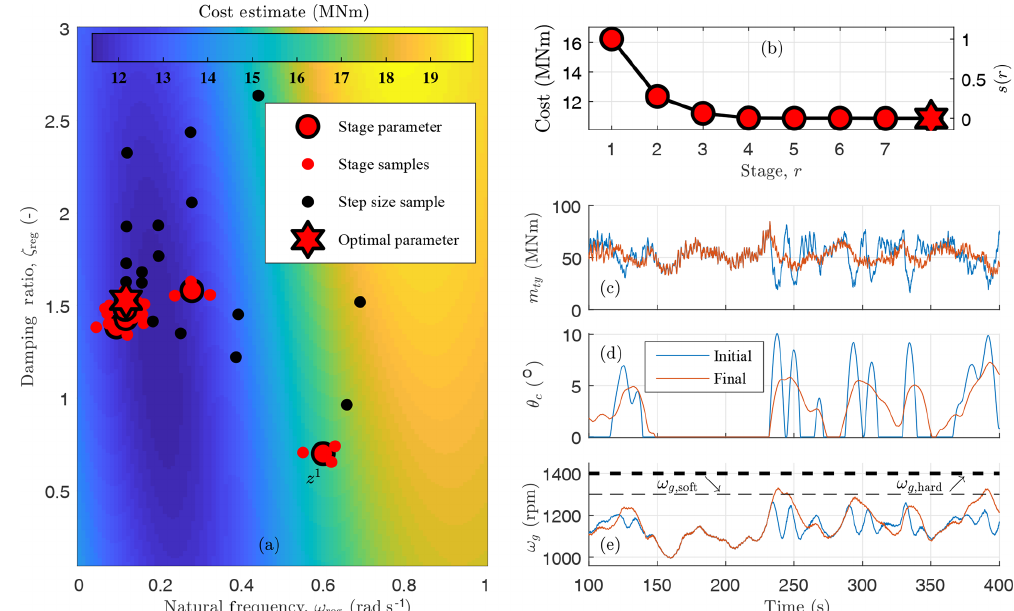
Figure 4. Results of using the zeroth-order optimization for tuning the pitch control regulator mode (natural frequency ω reg and damping ratio ζ reg ) of the 5MW reference turbine in Class B turbulence using the tower base fore–aft ( m ty ) DEL as the load measure, which is indirectly controlled via θ c , the collective blade pitch control; θ c is primarily responsible for regulating the generator speed ω g . The settling function s ( r ) is defined in Eq. (21). The cost estimate (background image in Fig. a) is determined after r = N stage = 7 stages (a total of 42 parameter pairs and